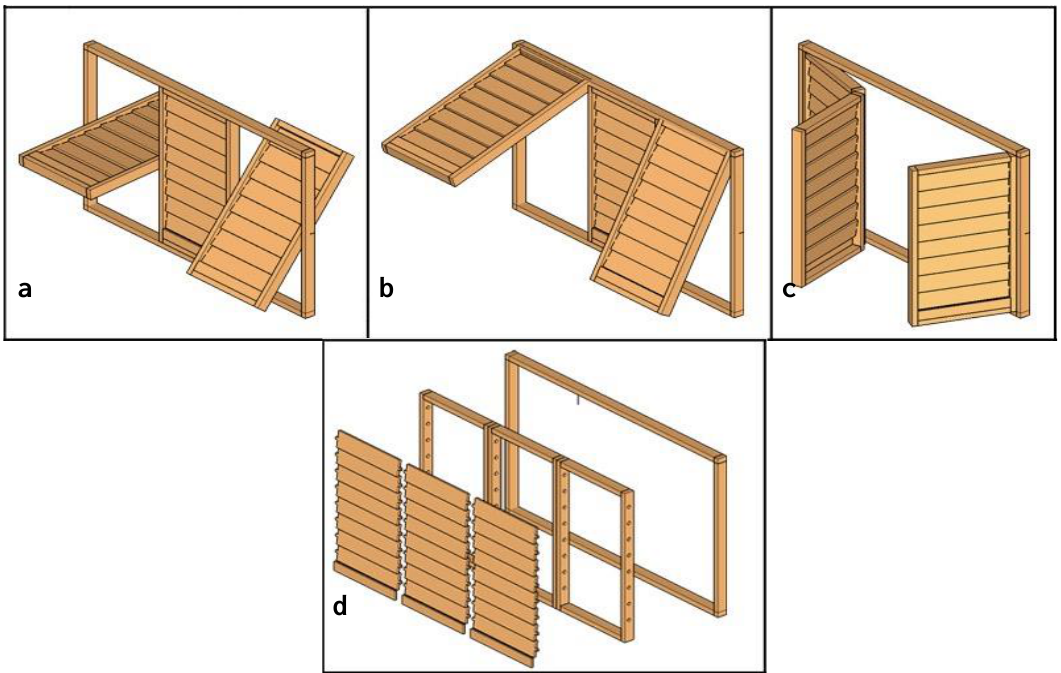
Figure 7.a, b, c, The figures show the renderings of the proposed modifications to the original MS design in (Fig. 6). Figure 7.d. Shows the components of the MS in an axonometric diagram which are the window frame casement, the 3 drafts casements with grooves and the MS louvers (Author,